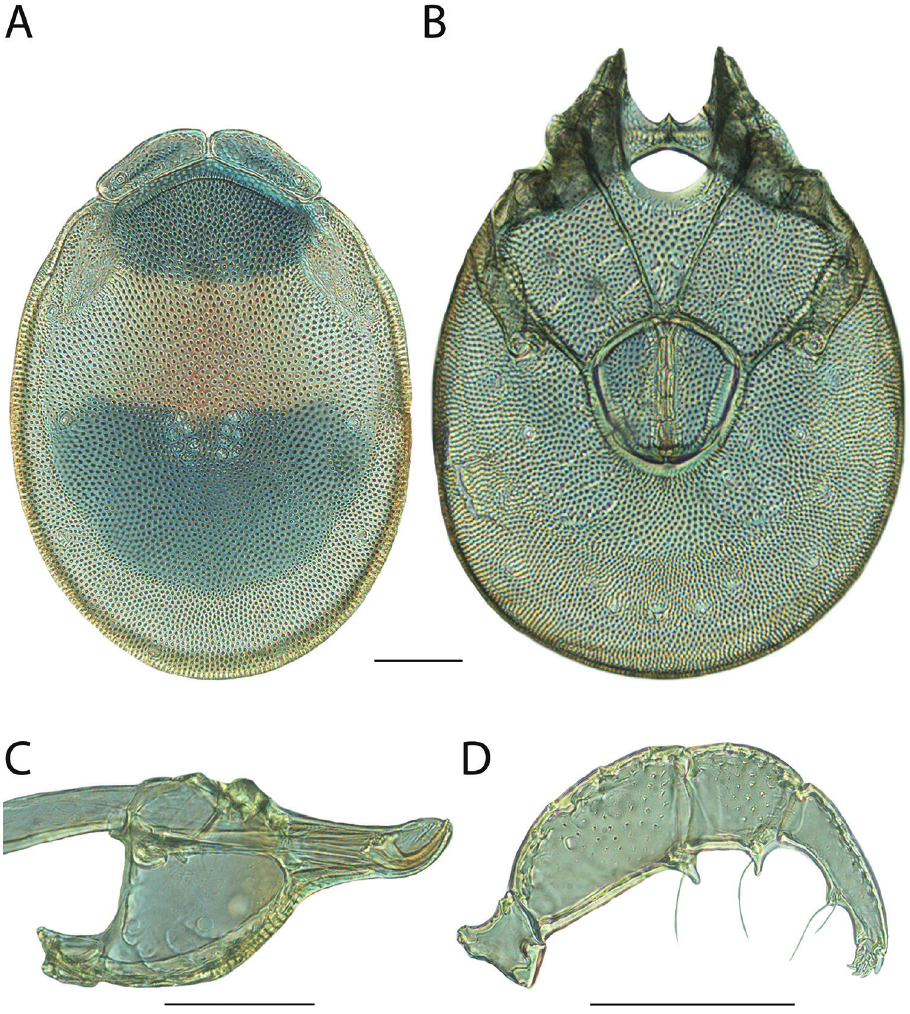
Figure 25. Torrenticola biscutella sp. n. female: A dorsal plates B venter (legs removed) C subcapitulum D pedipalp (setae not accurately depicted). Scale = 100